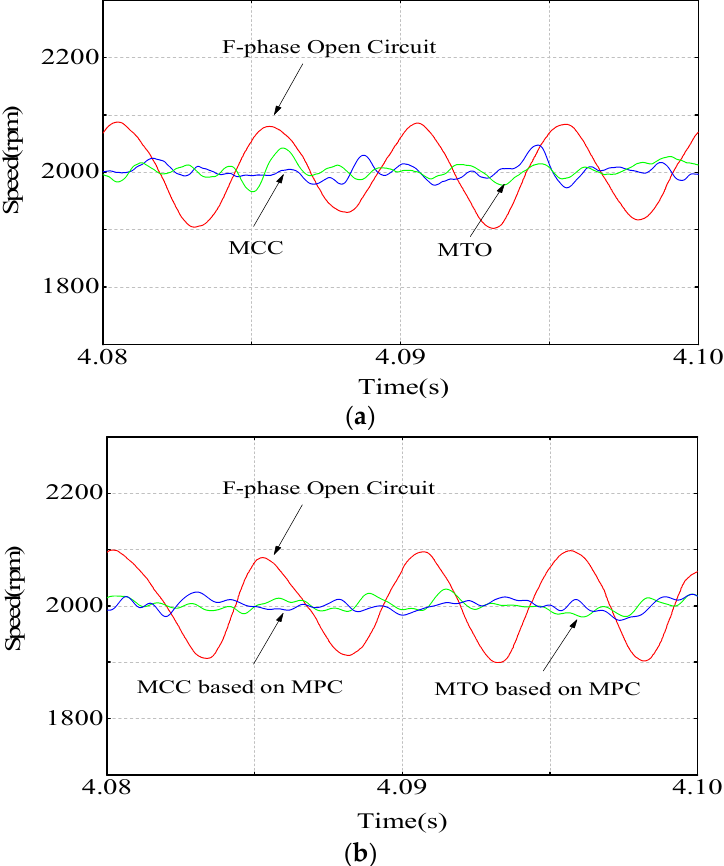
Figure 8. Speed of motor in fault operation and fault-tolerant control. ( a ) Fault-tolerant control with traditional MCC and MTO. ( b ) Fault-tolerant control with proposed MCC and MTO.